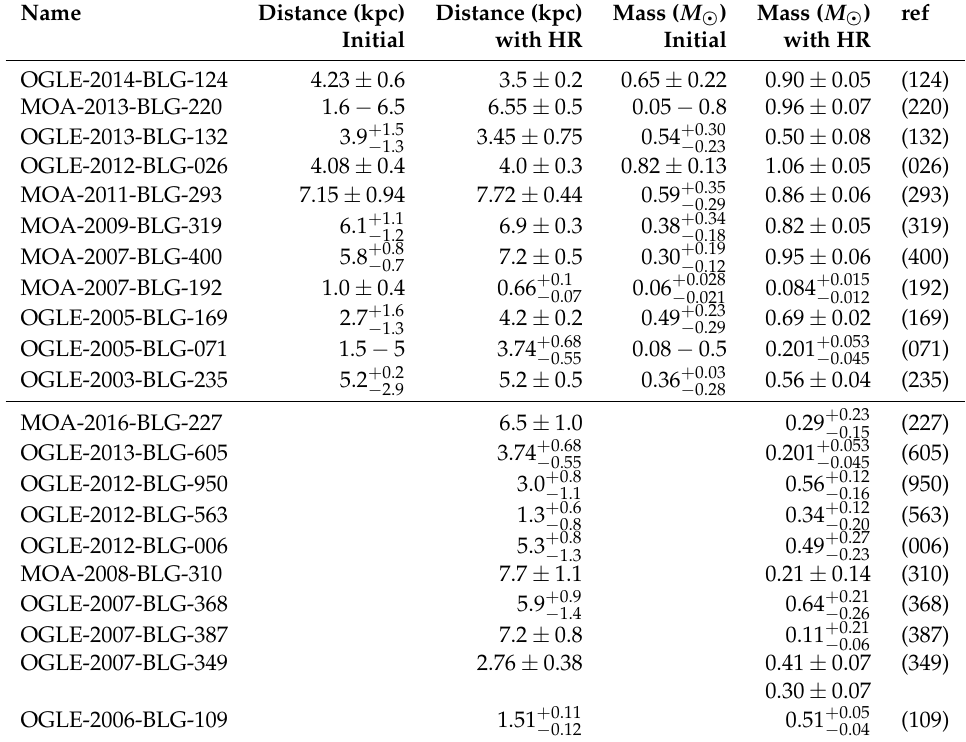
Table 1. Lens host masses and distances of planetary systems discovered by microlensing with constraints from high angular resolution constraints. We list the initial estimate if it was without high angular resolution with the label “initial”. If the initial study included high angular resolution it is then listed only with the label “with HR”. Otherwise, the HR labels indicate the current best estimates for mass and distances for these host stars. (124) [49,50], (220) [59,75], (132) [58,76], (026)